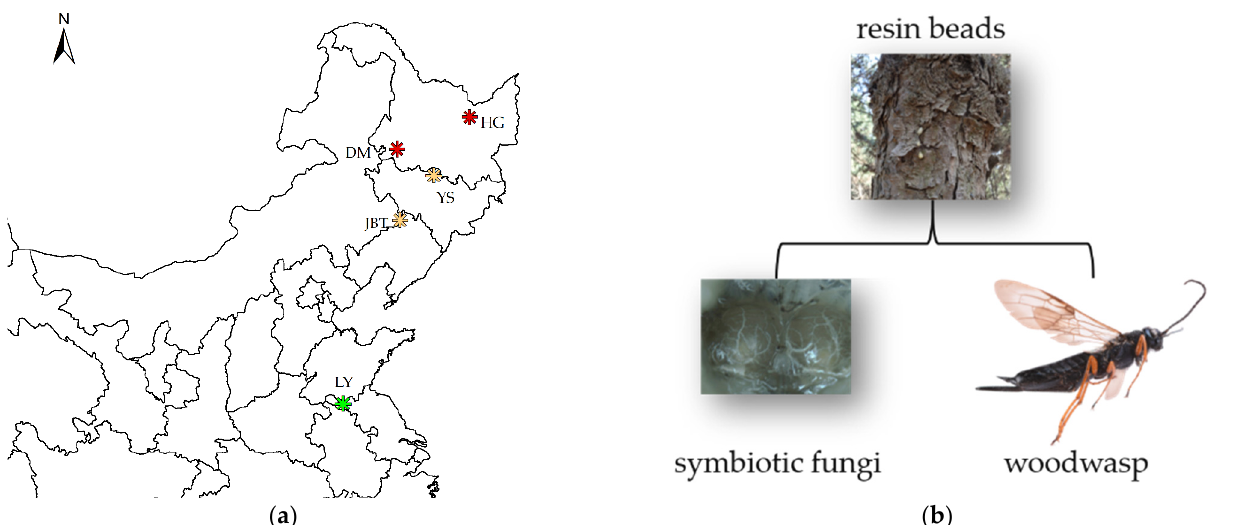
Figure 1. ( a ) Map of China highlighting the sampling areas (Jinbaotun (JBT), Yushu (YS), Linyi (LY), Dumeng (DM), and Hegang (HG)) in the current study; different colors represent different Sirex species present in China; red represents S. noctilio , green represents S. nitobei , and yellow represents co-occurring S. noctilio and S. nitobei . ( b ) Signs of infestation (resin beads) of woodwasp in the host tree and symbiotic fungi.